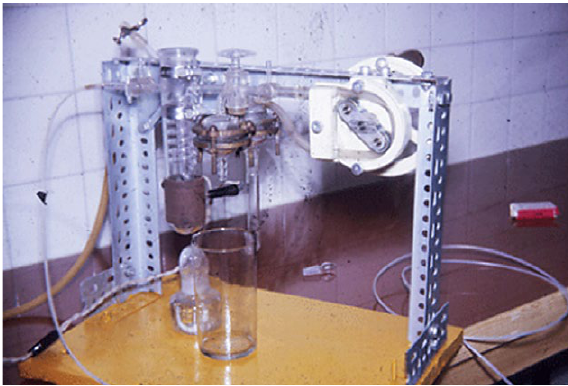
Fig. 10. – One of the devices for the automatic extraction of phy- toplankton pigments (Margalef 1961f). (Photograph: ICM